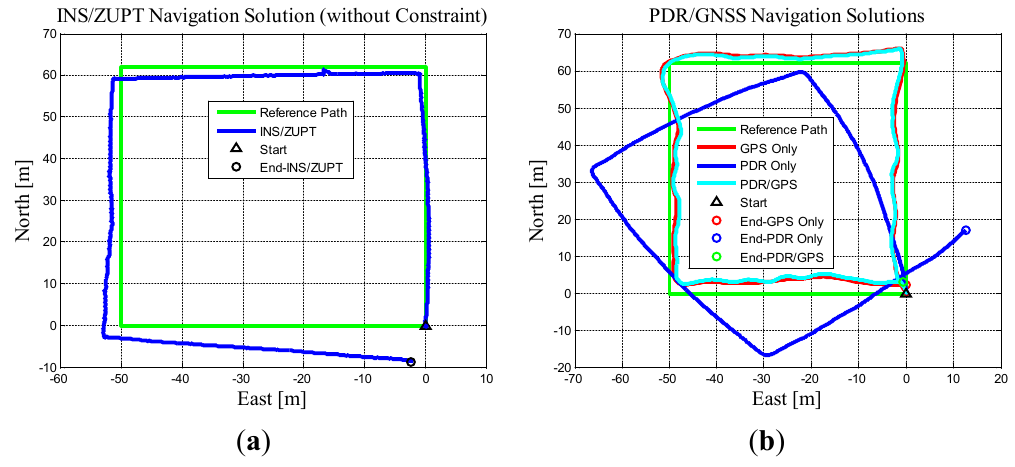
Figure 4. ( a ) INS/ZUPT system’s navigation solution; ( b ) PDR/GNSS system’s integrated navigation